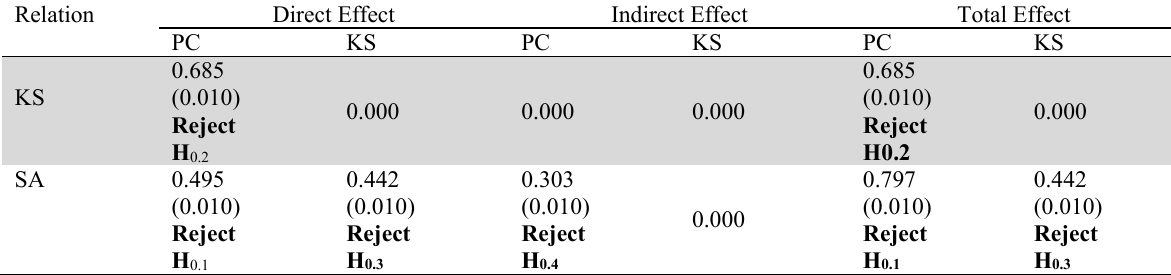
Direct, indirect and total effect model of mediation